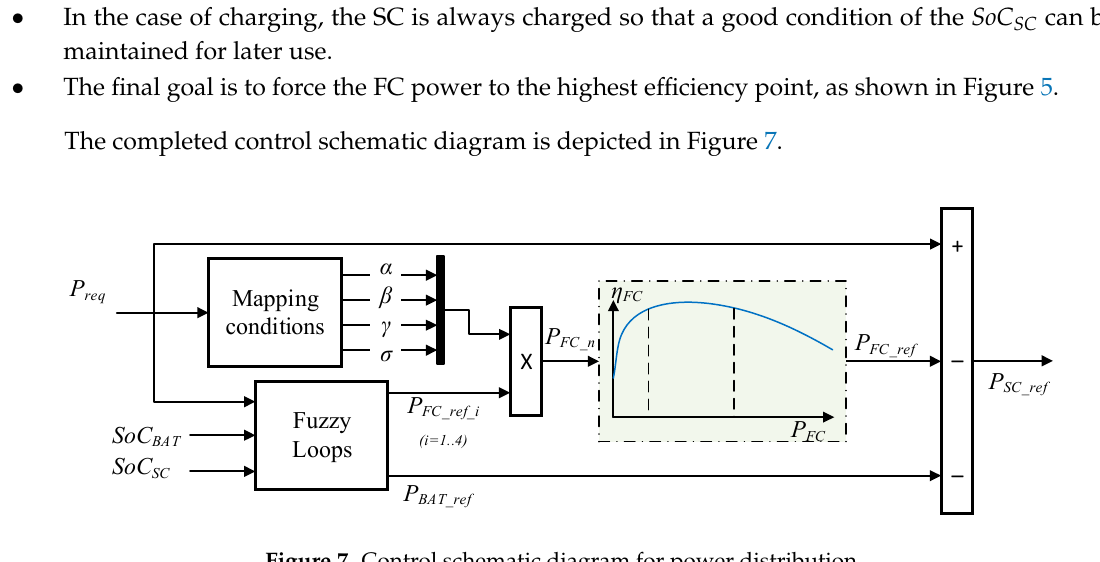
Figure 7. Control schematic diagram for power distribution.